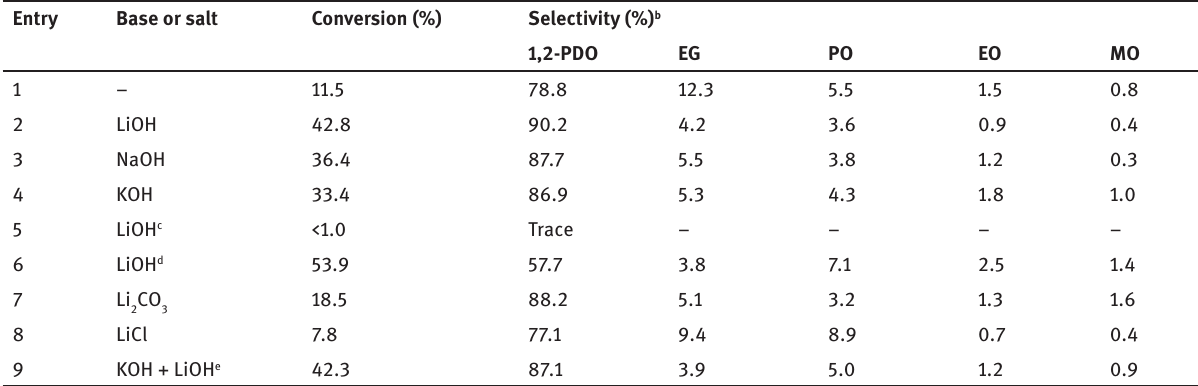
Entry Base or salt